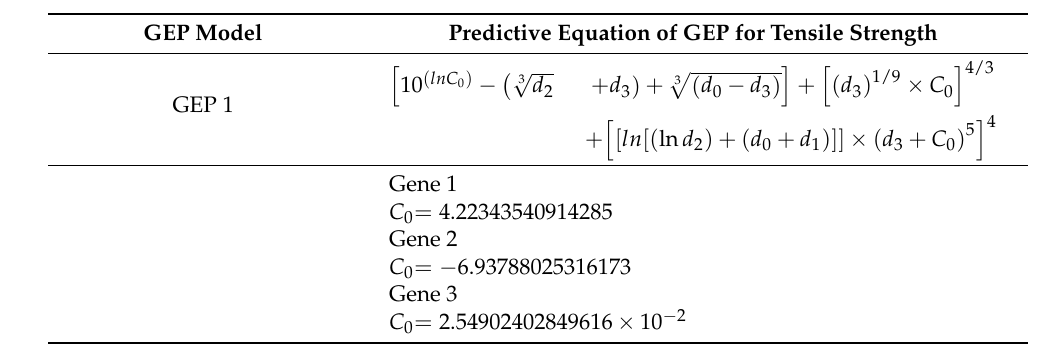
Table 9. The mathematical formulation of tensile strength of concrete samples containing nano-MgO proposed by the GEP tool.